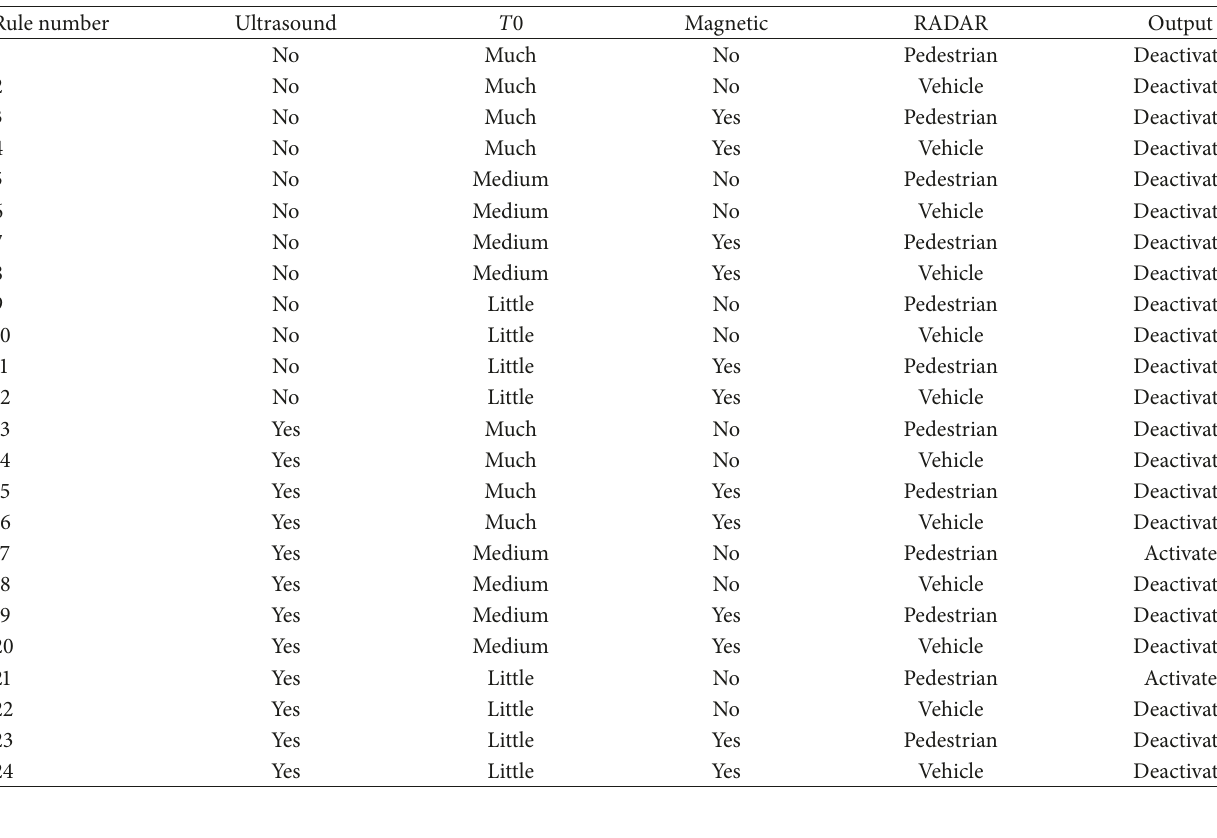
Table 7: Contingency table for the ROC analysis.